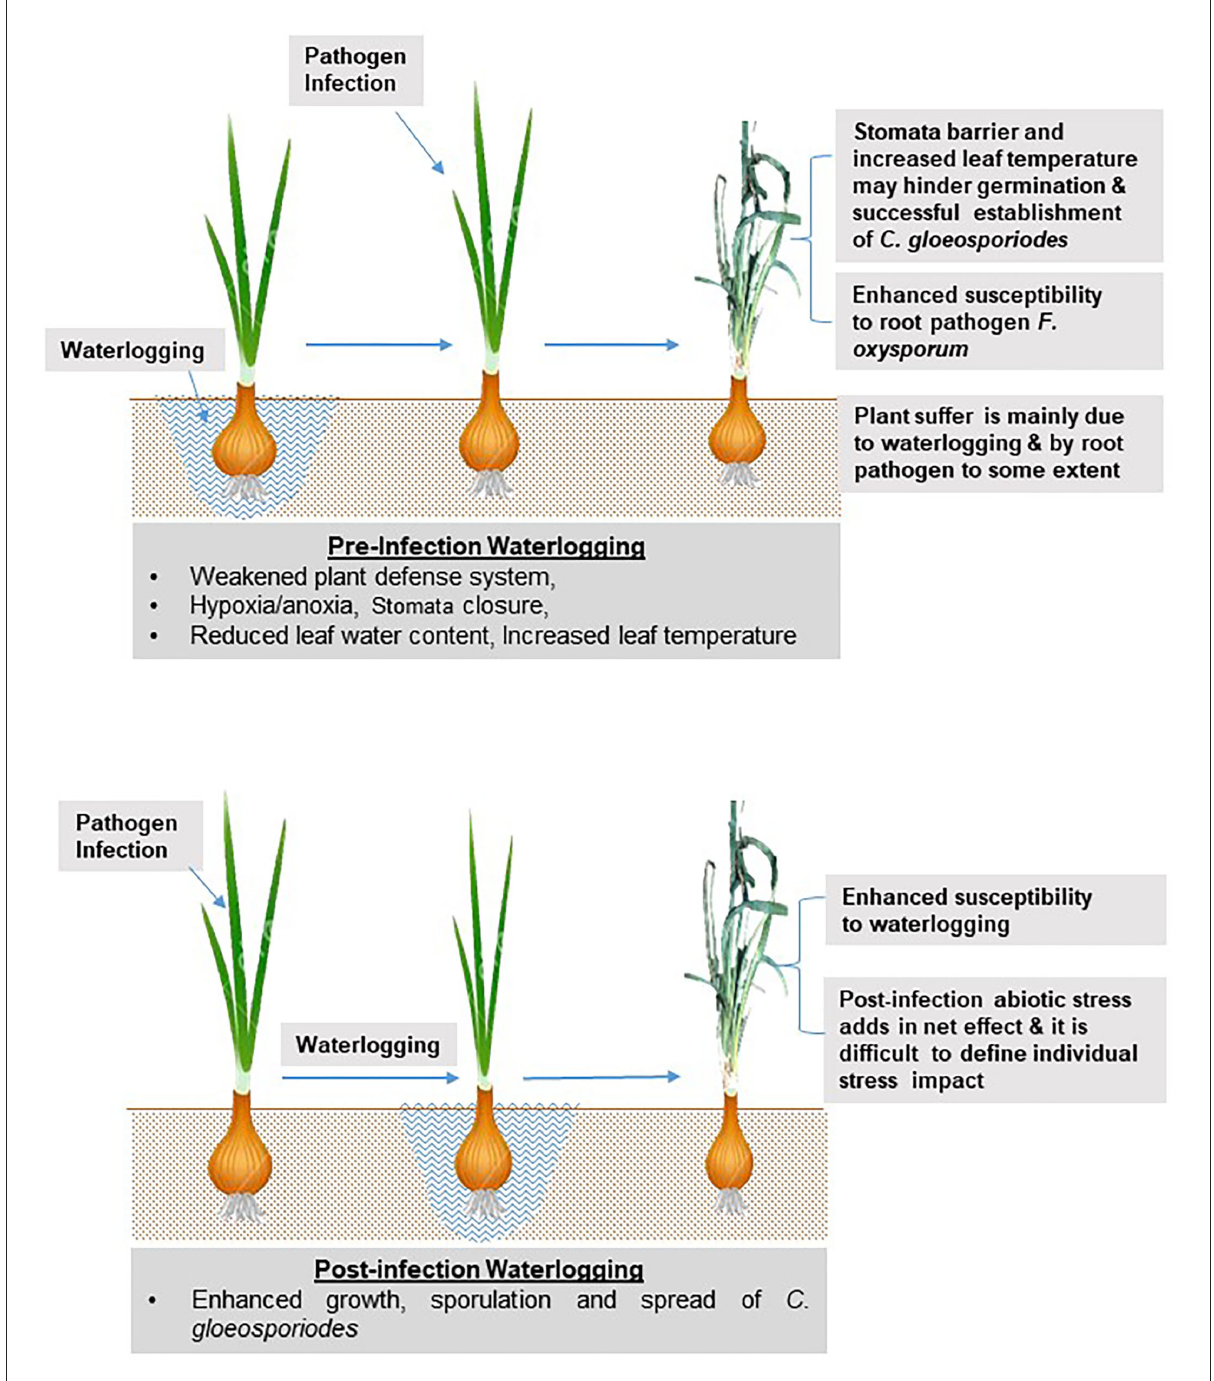
FIGURE7 Effect of combined waterlogging and anthracnose/twister disease on onion ( Allium cepa